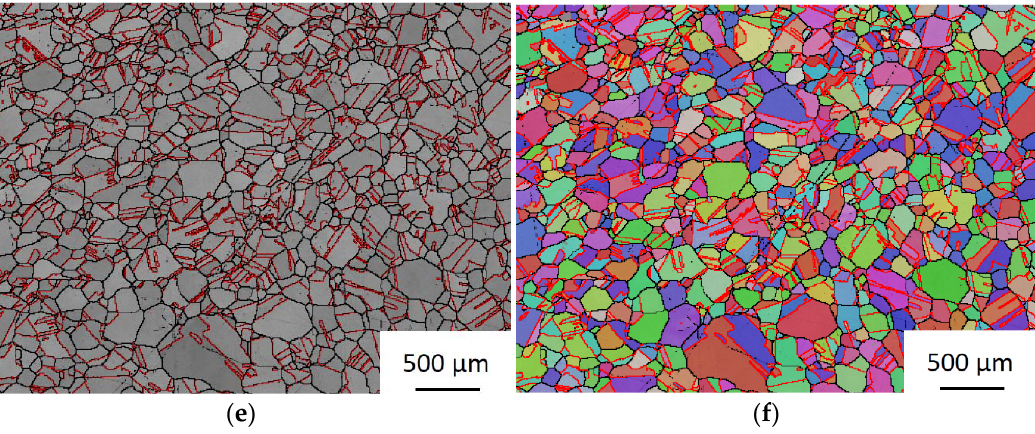
Figure 14. Electron backscatter diffraction (EBSD) analysis: ( a ) cast state band contrast and grain boundaries; ( b ) cast state IPF coloured grains and grain boundaries; ( c ) 5% deformation band contrast and grain boundaries; ( d ) 5% deformation IPF coloured grains and grain boundaries; ( e ) 25% deformation band contrast and grain boundaries; ( f ) 25% deformation IPF coloured grains and grain boundaries.